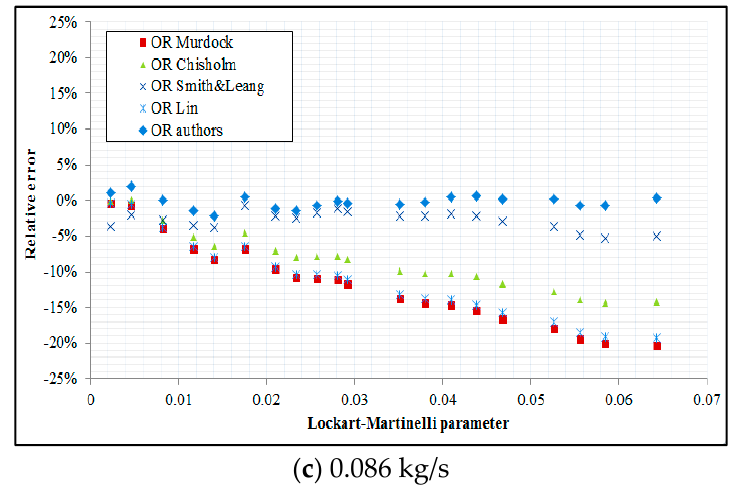
Figure 11. Comparison of relative error of parameter OR for various correlations applied for standard orifice in the conditions of constant air flow rates: 0.060 kg/s, 0.078 kg/s, 0.086 kg/s.